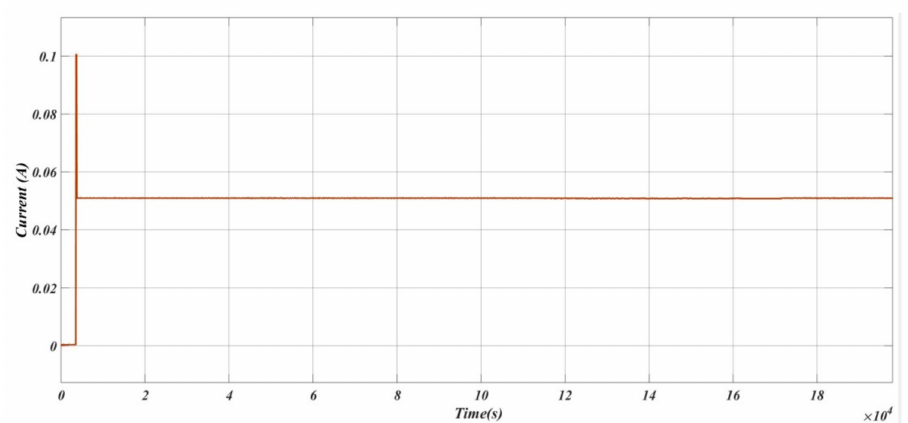
Figure 11. The pattern of the discharging current applied to the cell.